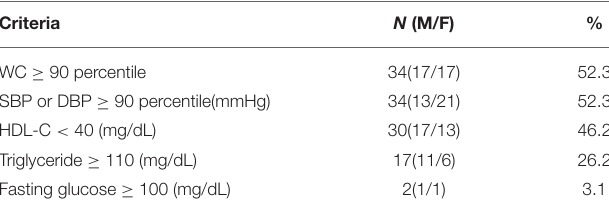
TABLE 1 | Prevalence of components of MS in obese